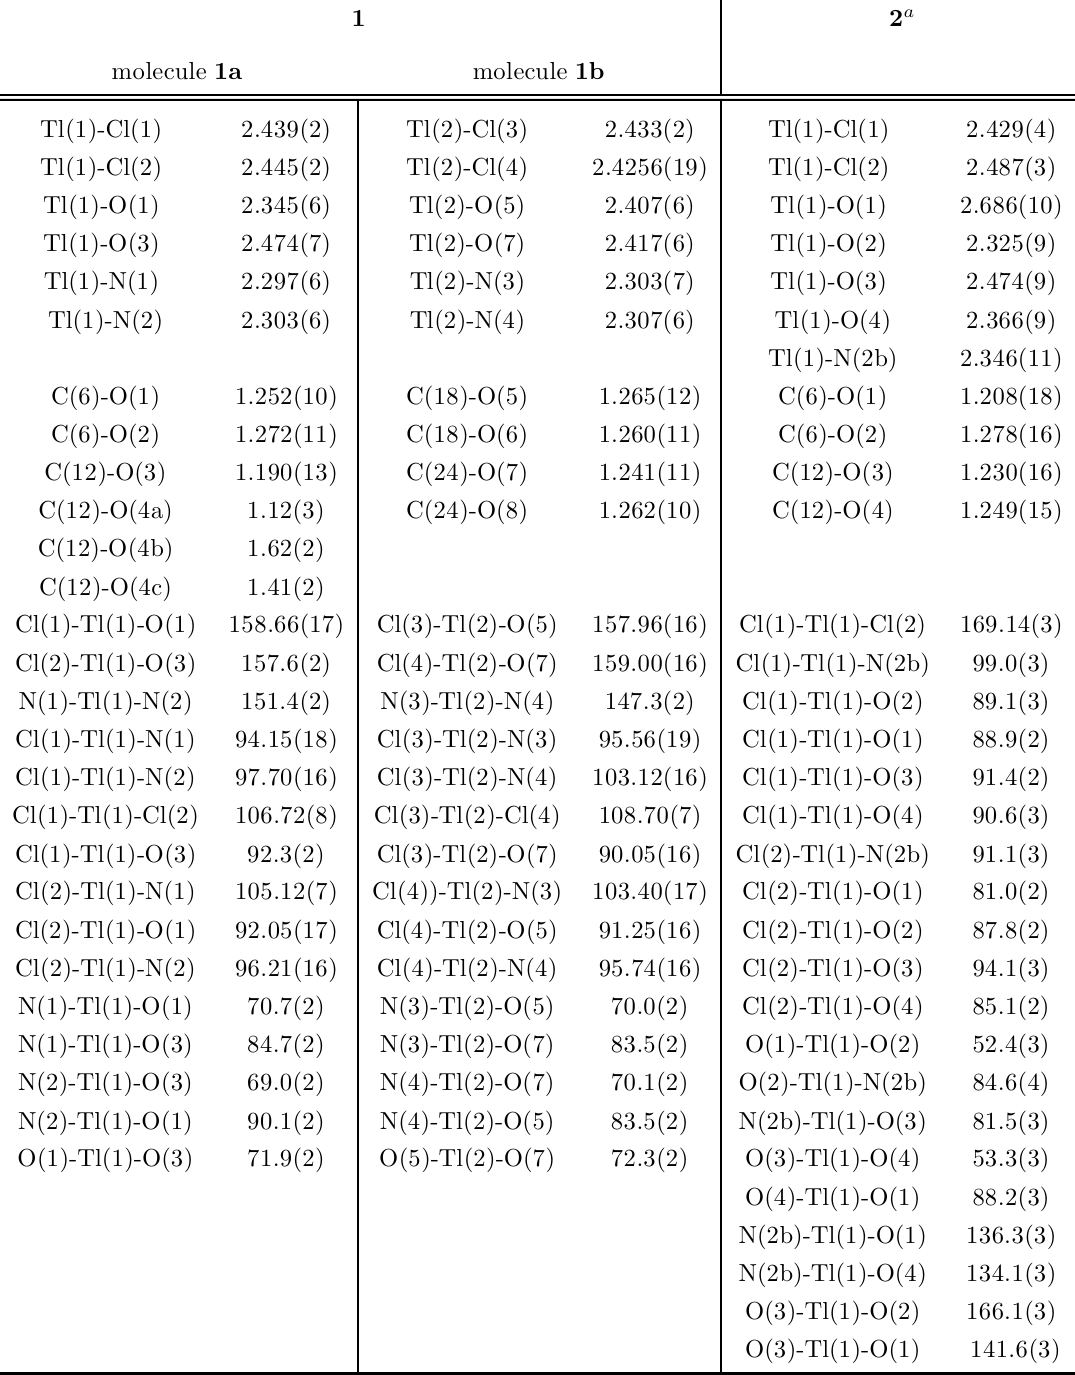
Table 4 Selected bond lengths (¸A) and angles (deg.) for compounds 1 and 2